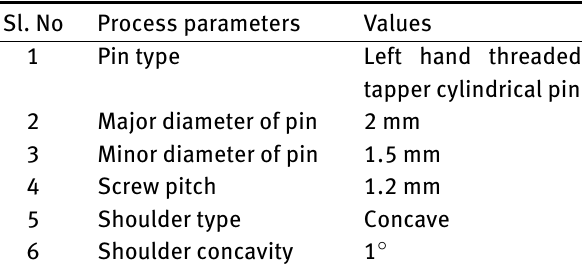
Figure 1: Micrograph of base metal Table 3: FSW tool dimensions